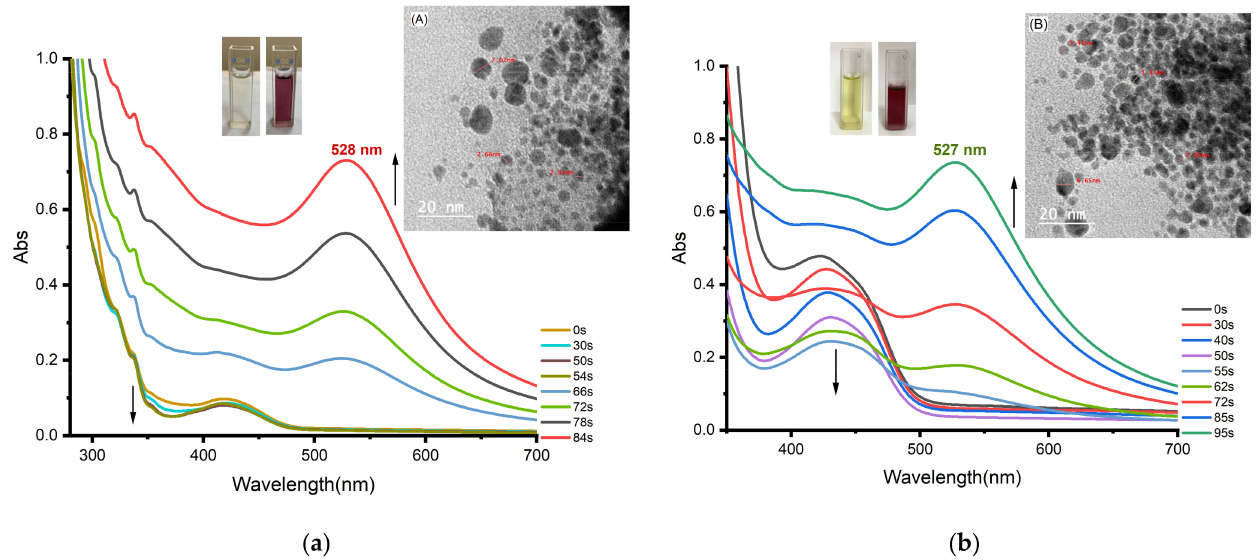
Figure 2. Evolution of the absorption spectra of the irradiated mixtures ( λ irr = 405 nm). Solution: (R3 ( a ) and R4 ( b )) 1 × 10 − 4 M gold chloride 3 wt% dissolved in 25 mL of DMF. TEM micrographs of gold nanoparticles of the R3/gold chloride 3 wt% ( A ) and R4 ( B